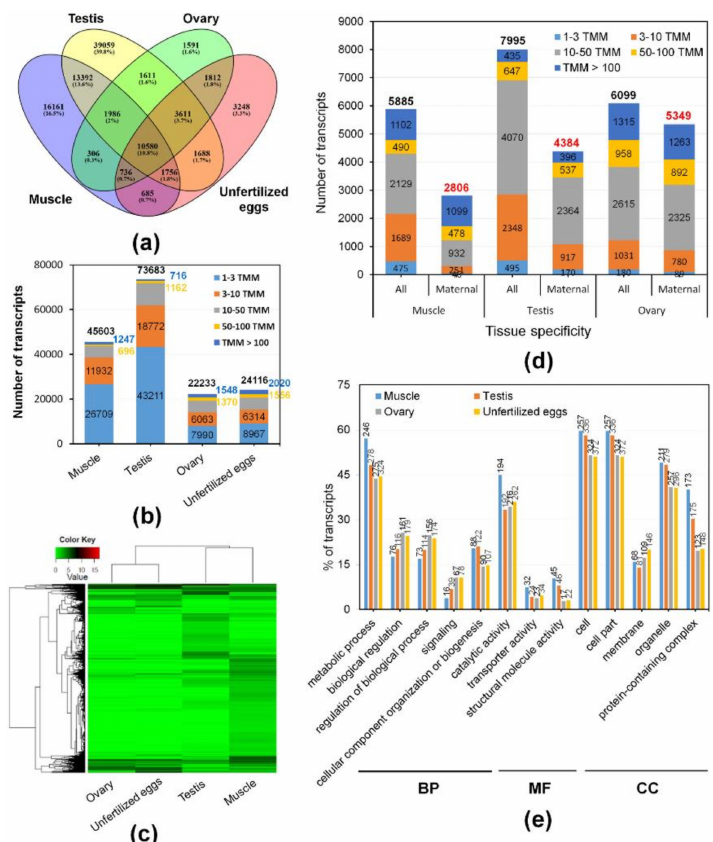
Figure 4. Expression analysis of transcripts in di ff erent tissues of M. anguillicaudatus and characterization ofmaternaltranscripts: ( a )overlappingcomparisonofexpressedtranscriptswithacut-o ff trimmedmean normalization of M-values (TMM) value < 1 in each tissue; ( b ) the number of transcripts with di ff erent di ff erences across tissues; and ( d ) the number and abundance of transcripts with tissue-specificity by the TissueEnrich tool, which were coexpressed in more than two tissues. “Maternal” in the horizontal axis represented transcripts that were coexpressed in the unfertilized eggs with other tissues; ( e ) GO